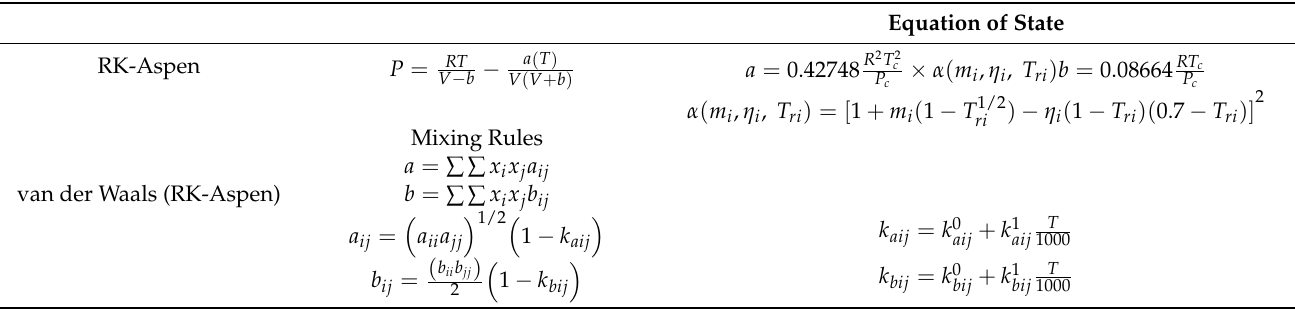
. and k bij = k 0 aij bij Equation of State